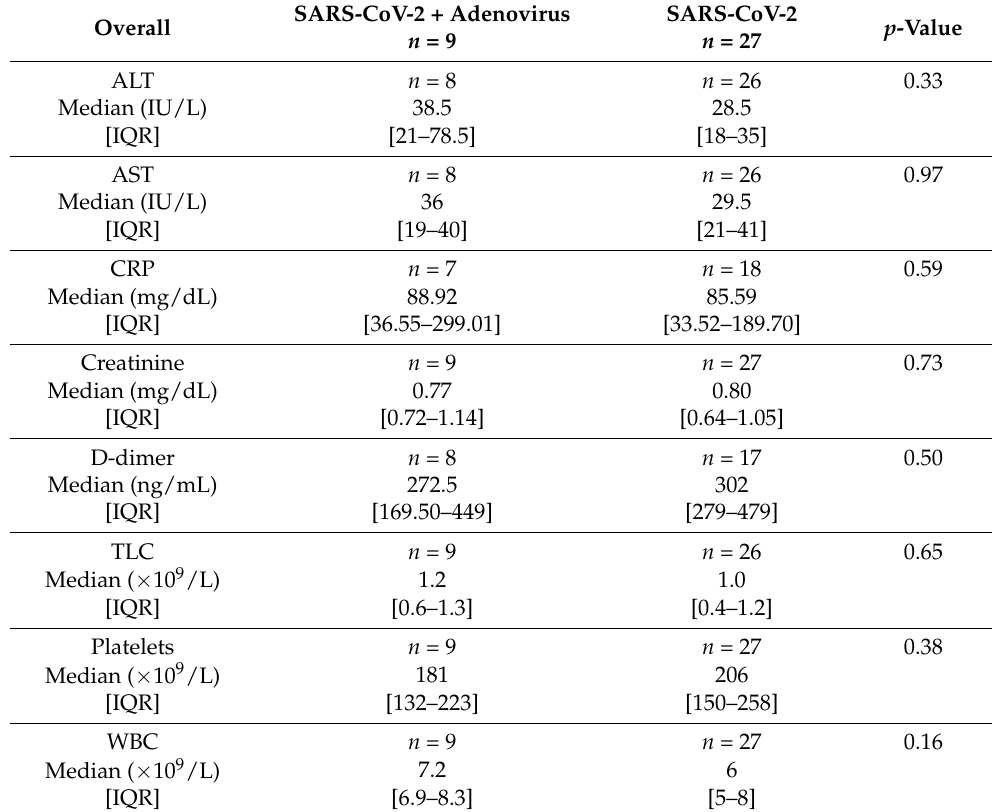
Table 7. Laboratory biomarkers on day of specimen collection between patients with SARS-CoV-2 + adeno- virus infection or SARS-CoV-2 mono-infection